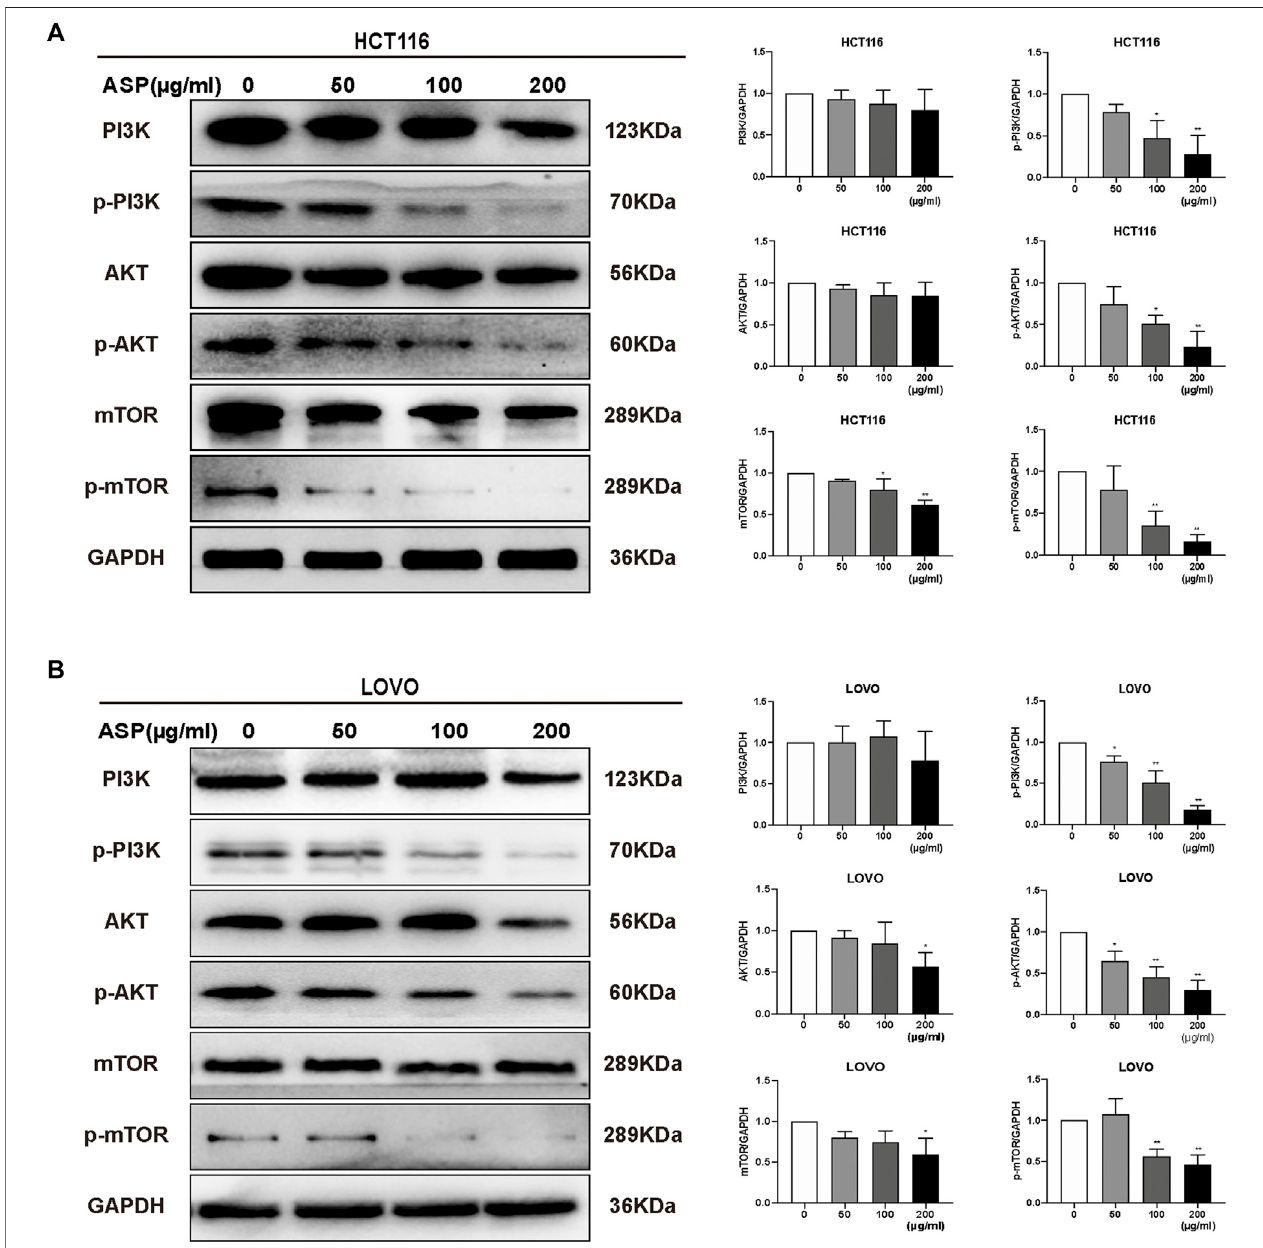
FIGURE9| ASPregulatesPI3K/AKT/mTORsignalingpathwaytoinduceapoptosisinCRCcells.InHCT116 (A) andLOVO (B) cells,thelevelsofPI3K/AKT/mTOR signaling pathway-related proteins were altered by ASP treatment ( n = 3 in each group). Values are shown as the mean ± SD, * p < 0.05, ** p < 0.01 vs . the control.